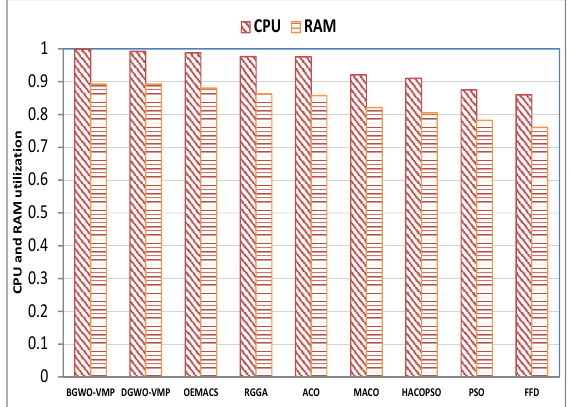
Figure 4. Mean utilizations of CPU and RAM for all active PMs on